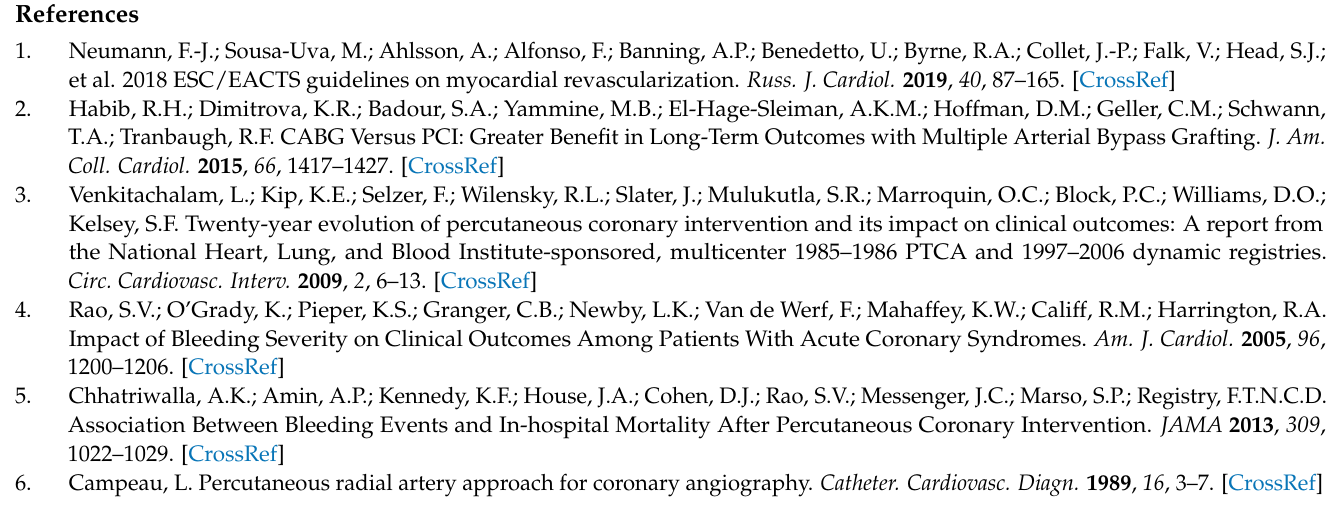
Figure S5: Risk of bias pf the included studies, Table S1: Main clinical, angiographic and procedural characteristics of the included